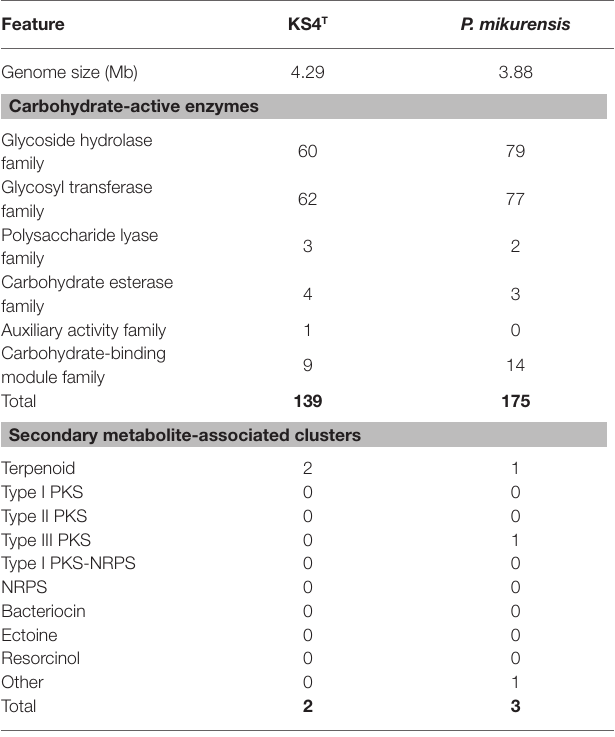
TABLE 2 | Numbers of carbohydrate-active enzymes and secondary metabolite- associated gene clusters.